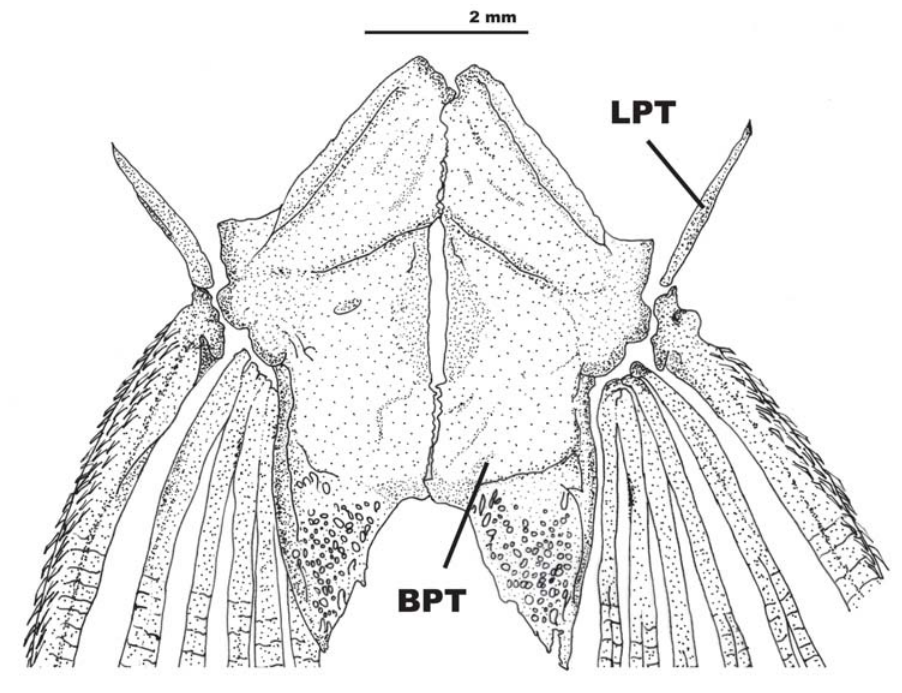
Fig. 7. Pelvic girdle in dorsal view of Gymnotocinclus anosteos , MCP 41726, paratype, male, 40.5 mm.